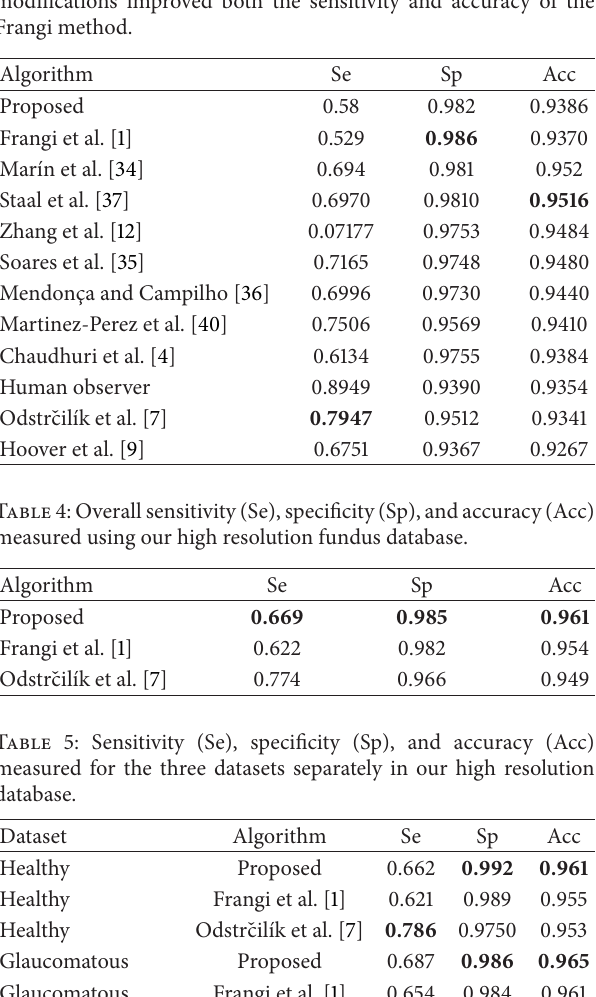
Table 6: Comparison of average runtime using two public data- bases. The effects of the proposed modifications on the calculation time in seconds as shown.